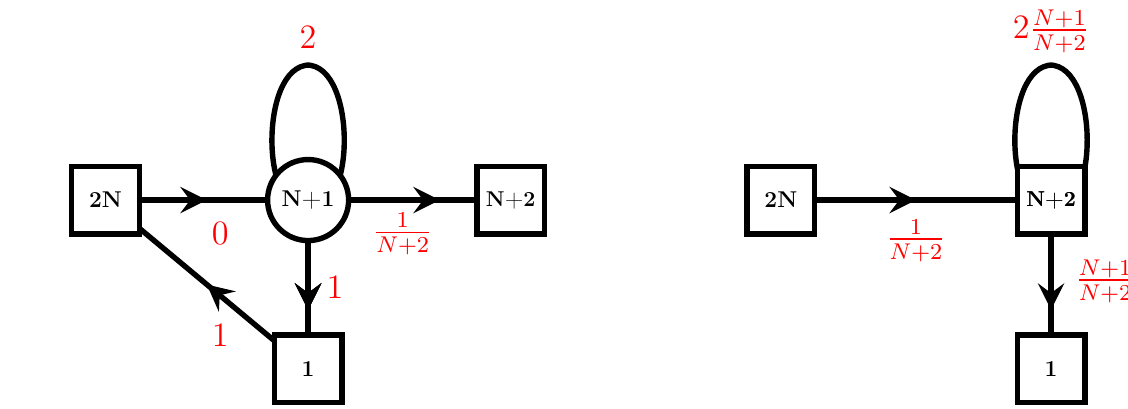
Figure 20: A version of SWV duality with an additional field and a superpotential. We split N + 3 to ( N + 2 ) + 1 and add chiral field in fundamental of USp ( 2 N ) which couples to the rest through a cubic superpotential corresponding to a triangle in the